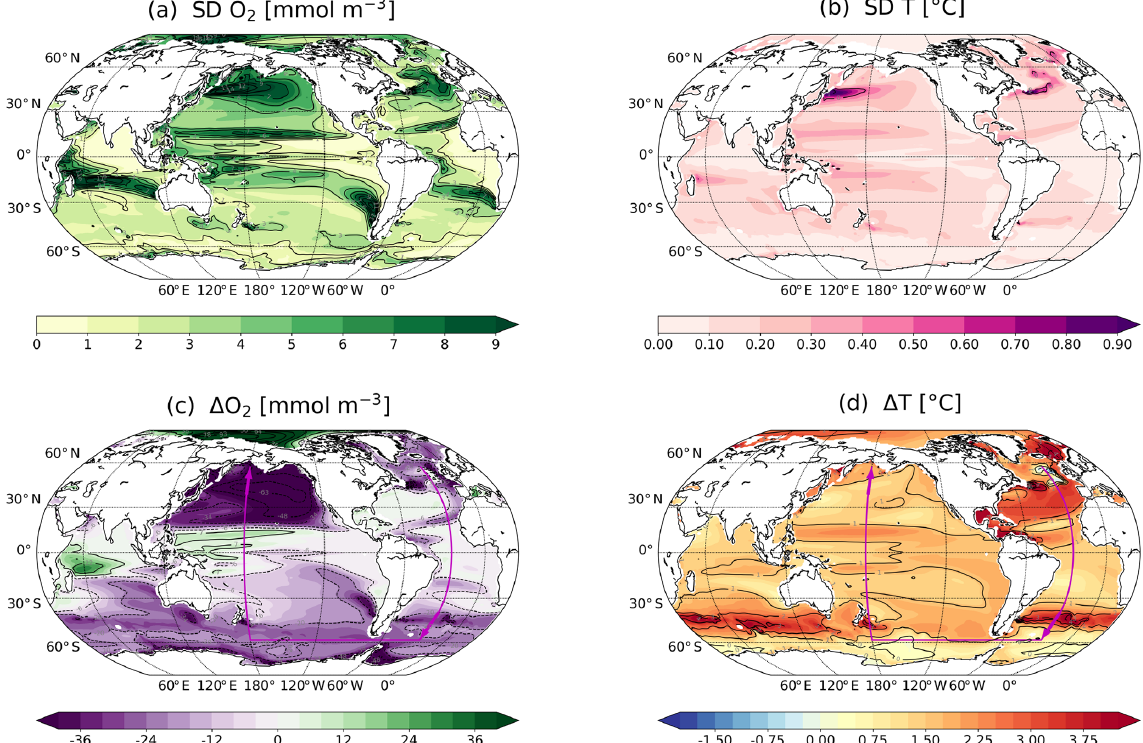
Figure 3. Standard deviations for (a) O 2 and (b) T as computed for the period 850 to 1800CE for the thermocline (200–600m). Anthro- pogenic changes ((2070–2099) minus (1720–1800)) in (c) O 2 and (d) T in the thermocline. O 2 and T are annually and vertically averaged and SD and changes are computed from these averaged values. The magenta arrows in panels (c) and (d) indicate the section shown in Fig. 9 (Atlantic: 25 ◦ W; Southern Ocean: 60 ◦ S; Pacific: 150 ◦